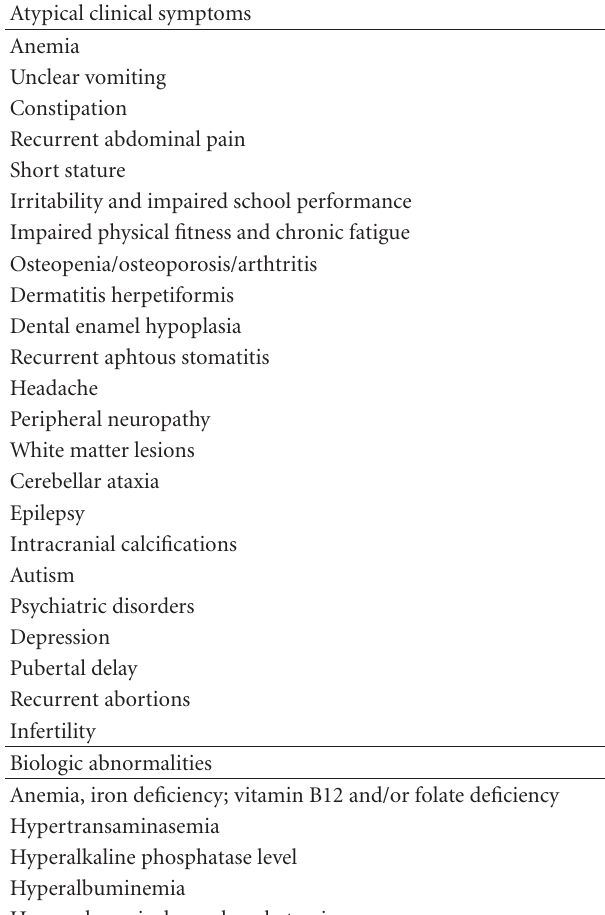
Table 1: Clinical and biological revealing circumstances of atypical CD.